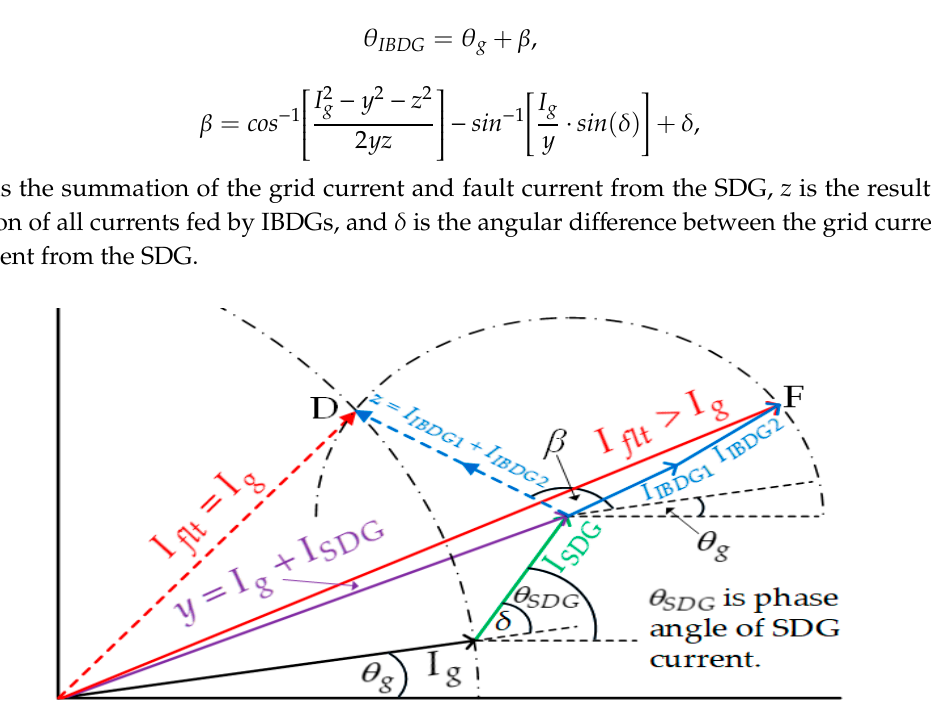
Figure 1. Phasor diagram of the modified current phase angle calculation.